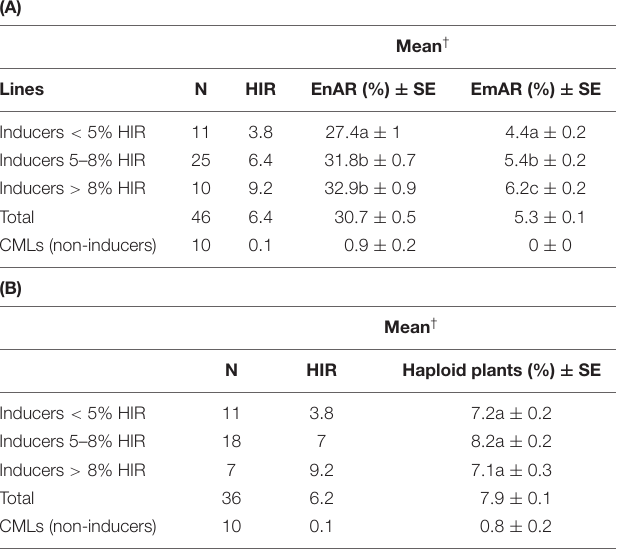
TABLE 5 | HIR associated traits of (A) EnAR and EmAR, and (B) proportion of haploid plants in inducers and non-inducers and in inducers with different levels of